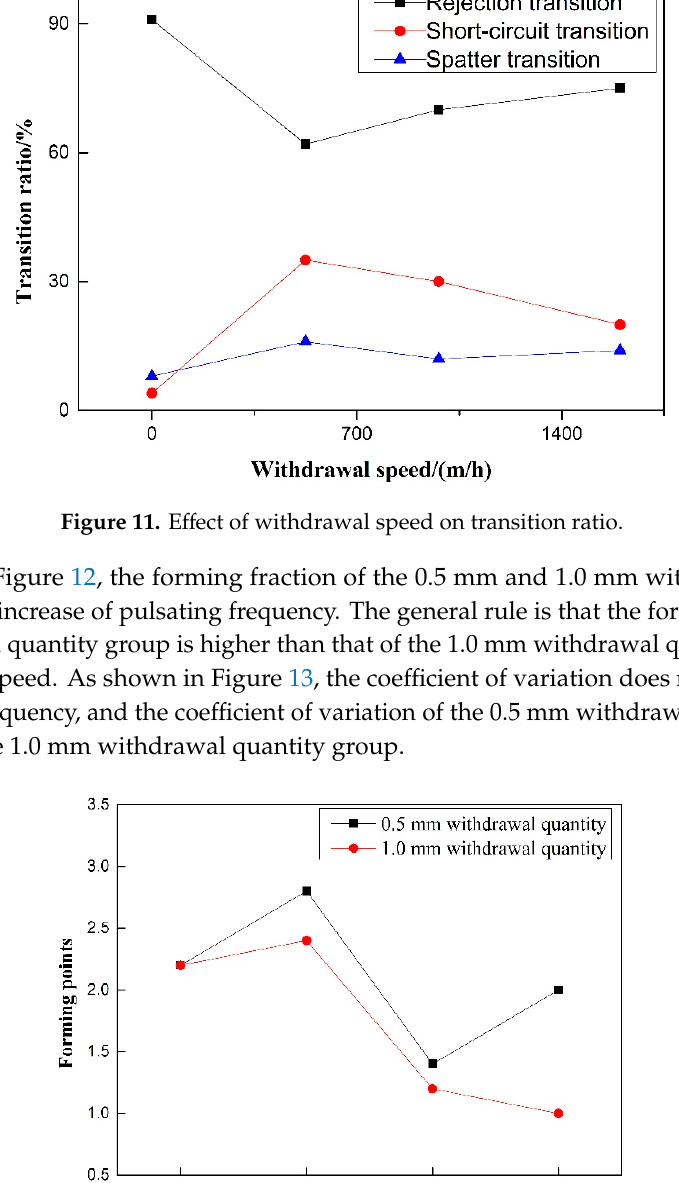
Figure 13. Effect of withdrawal speed on coefficient of variation under different withdrawal quantity. Under the precondition of eliminating the influence of wire withdrawal speed, it can be seen in Figures 14 and 15 That, for rejection transition, the transition ratio increases first and then decreases with the increase of pulsating wire feeding frequency at the 0.5 mm withdrawal quantity, and the overall trend is upward. At 40 Hz, the rejection transition ratio reaches a maximum of nearly 80%. At the 1.0 mm withdrawal quantity, the rejection transition ratio increases with the increase of pulsating wire feeding frequency. However, the absolute value is smaller than that of the 0.5 mm withdrawal, and the rejection transition ratio is more than 50% at 60 Hz pulsating frequency. The rejection transition ratio of pulsating wire feeding under the 0.5 mm withdrawal quantity is significantly higher than that under the 1.0 mm withdrawal quantity. For short-circuit transition, the transition ratio decreases with the increase of the pulsating frequency at 0.5 mm and 1.0 mm withdrawal quantities, but the slope of the 1.0 mm withdrawal is smaller than that of the 0.5 mm withdrawal. At the same frequency, the short-circuit transition ratio is significantly higher under the 1.0 mm withdrawal quantity than that under the 0.5 mm withdrawal quantity. The spatter ratio is negatively correlated with pulsating wire feeding frequency under the 0.5 mm and 1.0 mm withdrawals. From a numerical point of view, the spatter ratio under the 0.5 mm withdrawal is lower than 30% and the minimum value is 3.1% at 40 Hz. Meanwhile, the spatter ratio under the 1.0 mm withdrawal is higher than 27% and the maximum value is close to 35%. It can be seen that the welding spatter ratio of the 0.5 mm withdrawal quantity is significantly less than the 1.0 mm withdrawal quantity.